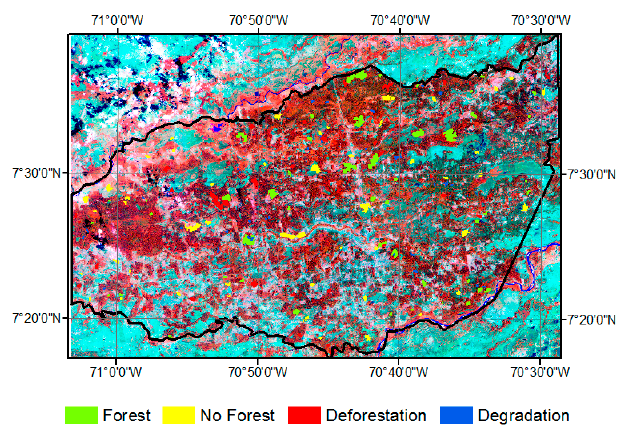
Figure 2. Distribution of sampling objects or region based on a stratified random approach, here applied to the 2000 image.